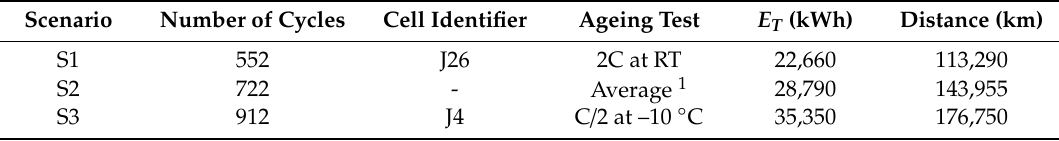
Table 6. Battery cycling scenarios from ageing test results